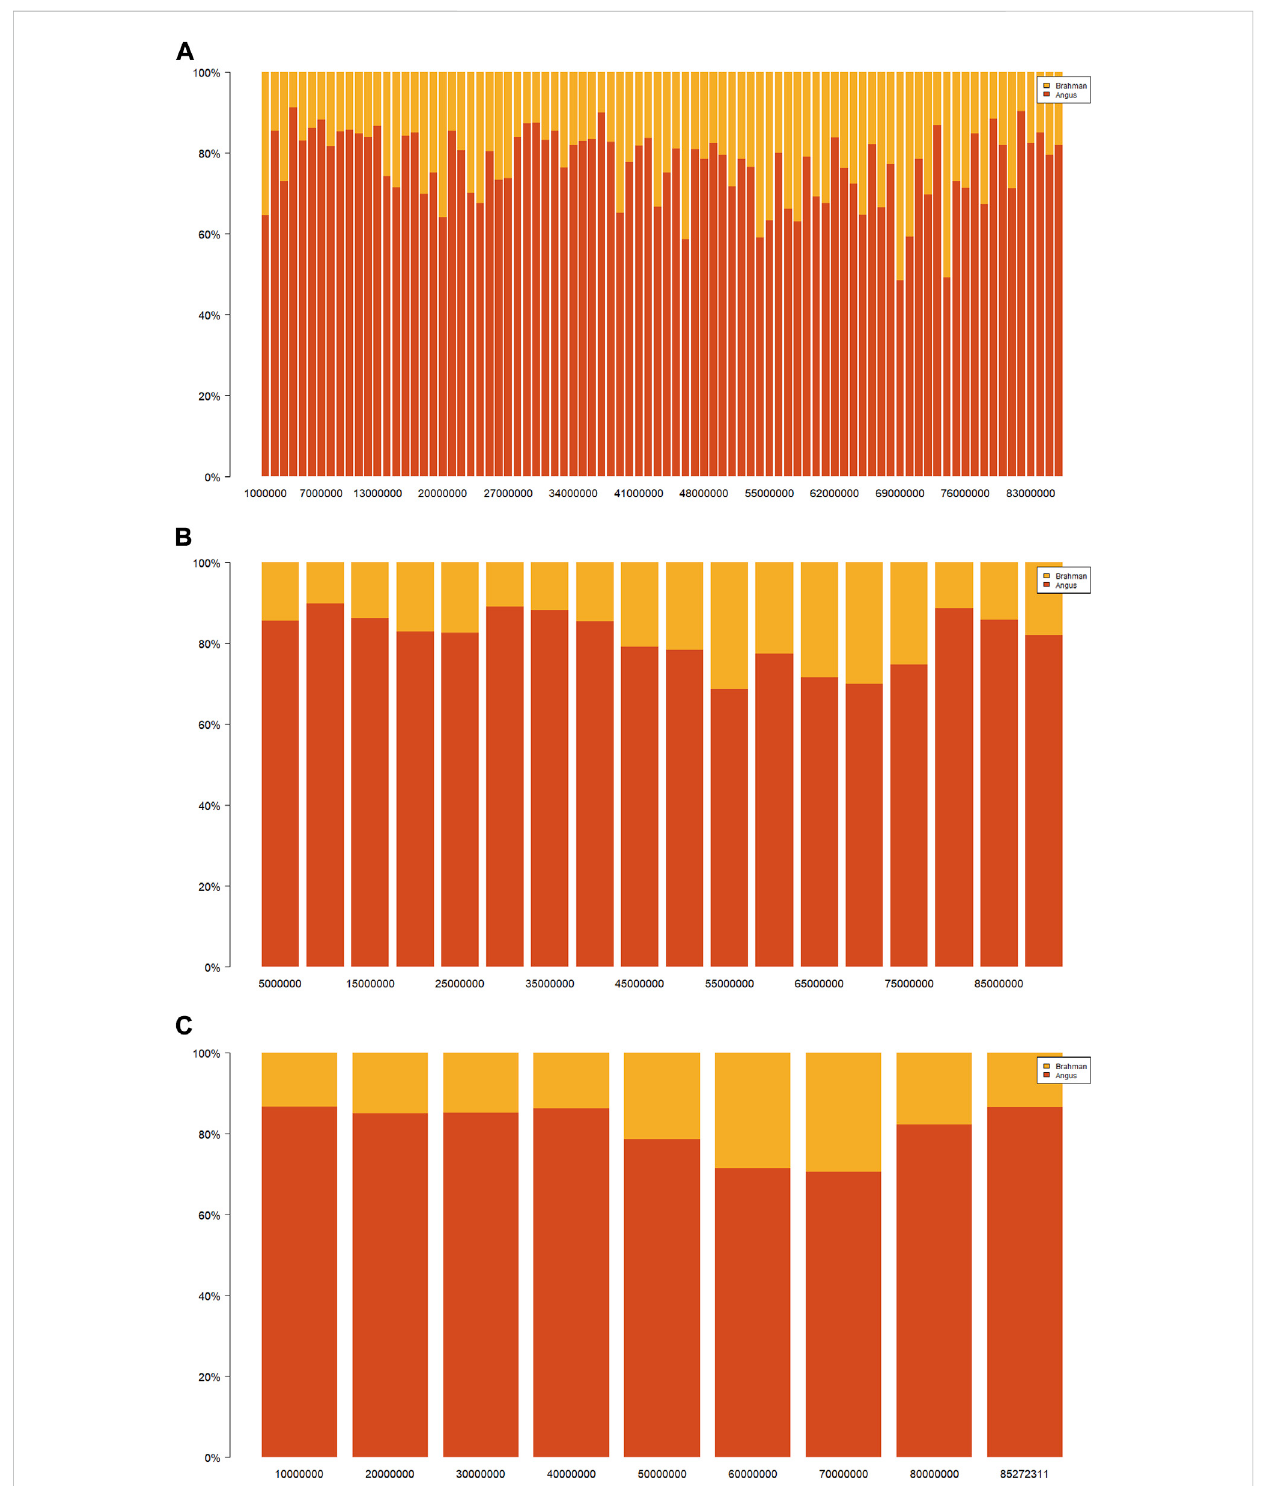
FIGURE 3 DistributionsofAngus(red)orBrahman(yellow)breedproportionsbyvaryingwindowsizesonchromosome15in3,605Branguscattle: (A) 1 Mb, (B) 5 Mb,and (C) 10 Mb.Theblackdashedlinerepresentsthepopulationmeanoftheestimatedgenomic-estimatedbreedcompositions(GBC),andtheblue dashed line represents the population mean of the chromosomal-estimated breed compositions